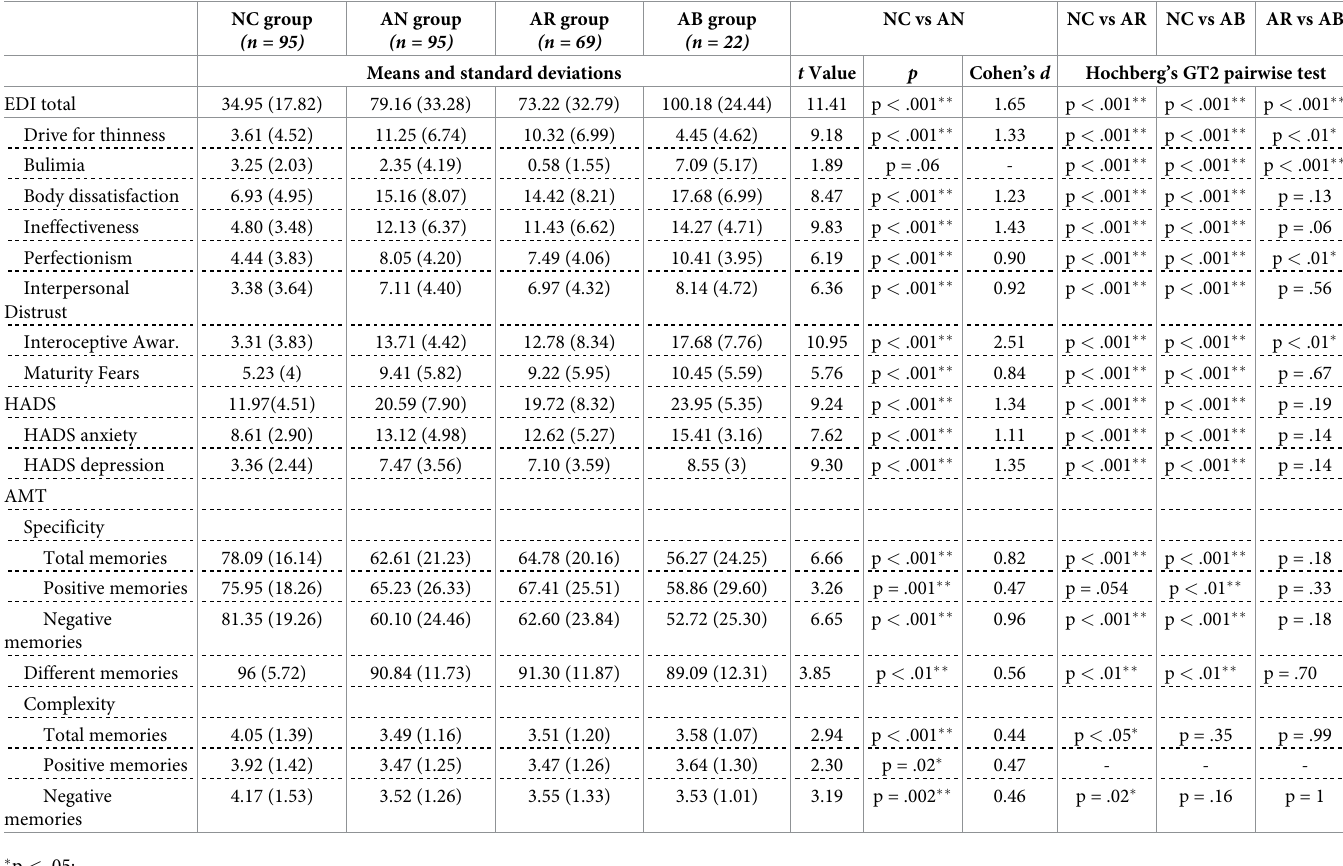
Table 3. Descriptive statistics and group comparisons ( t test or Hochberg’s GT2 pairwise test) between NC and anorexic groups for clinical and autobiographical memory